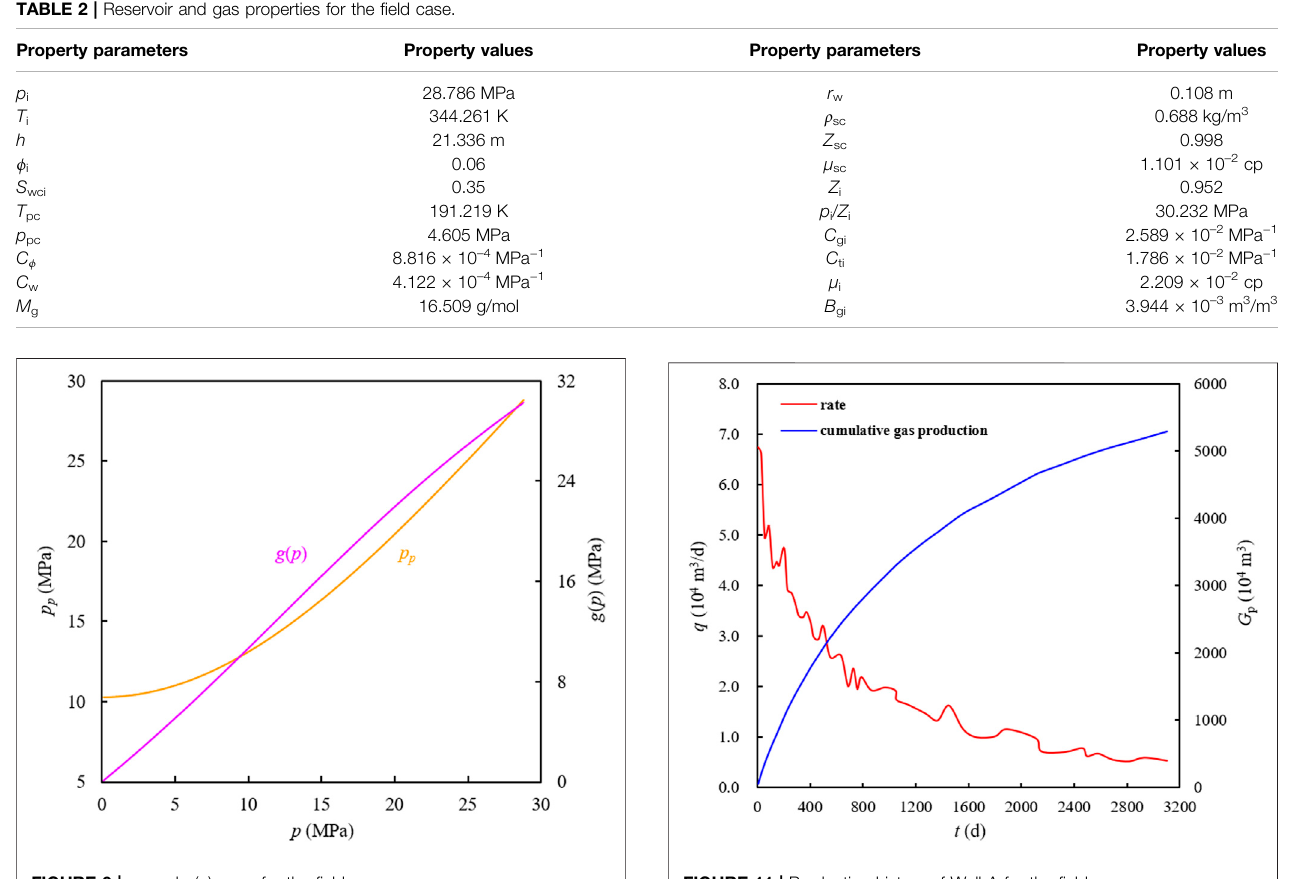
FIGURE 11 | Production history of Well A for the fi eld